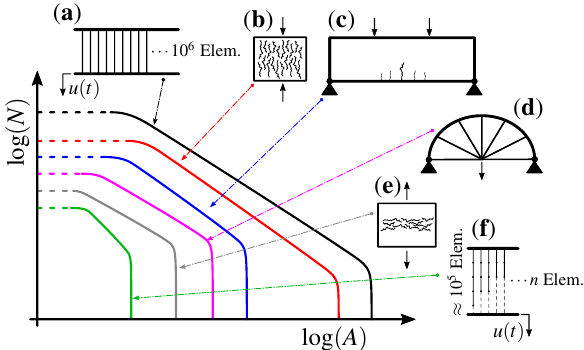
Figure 16. Frequency distribution of some measure of avalanches magnitudes in different struc- tural